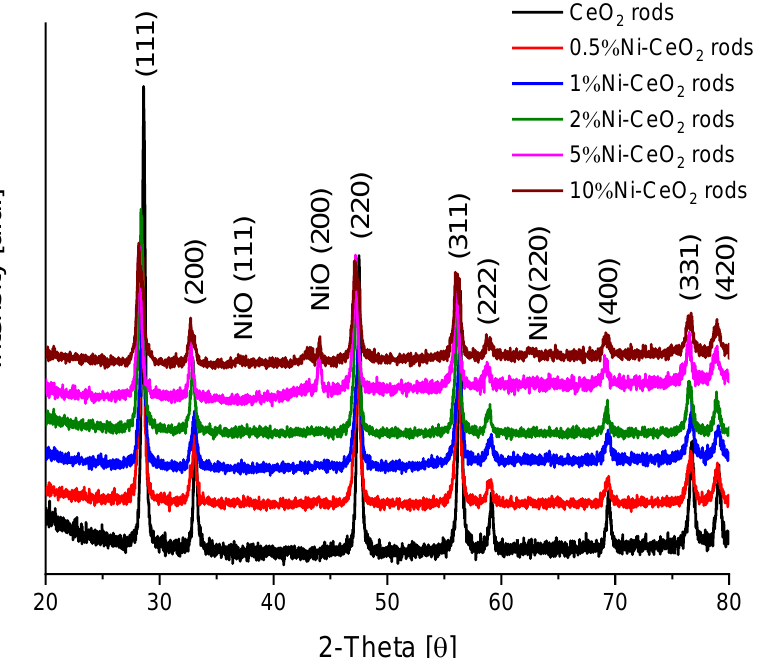
Figure 10. XRD patterns for Ni-CeO 2 -rods catalysts.